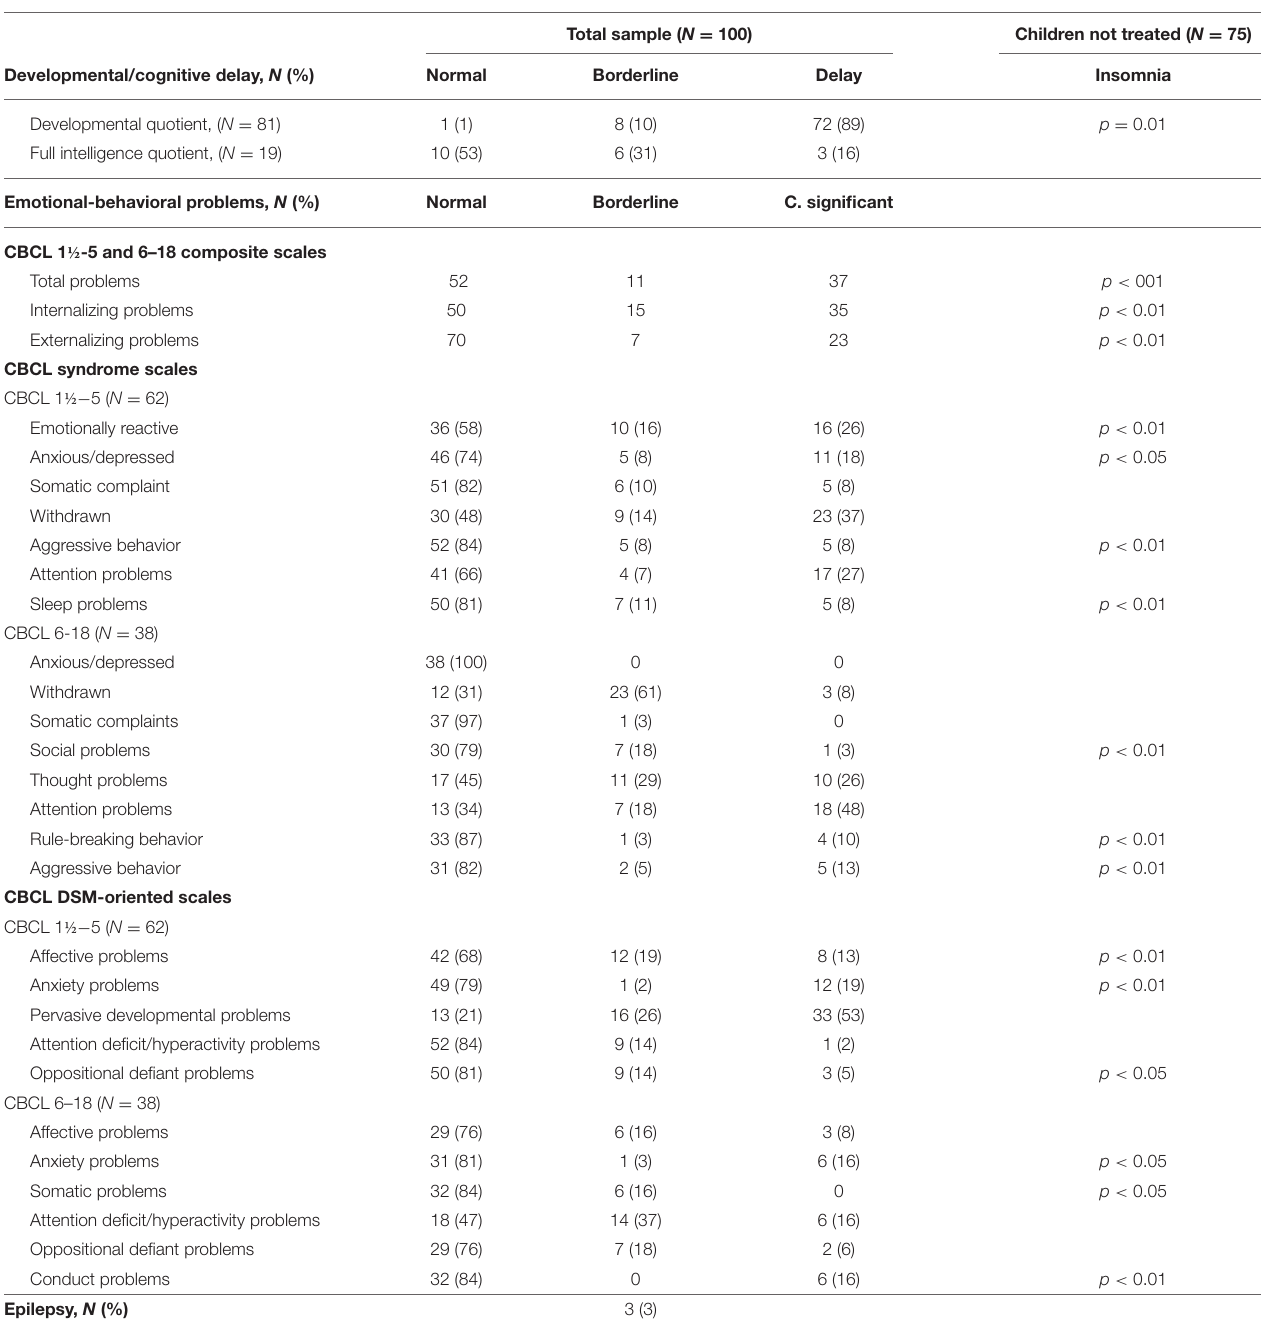
TABLE 3 | Comorbidities of the sample.